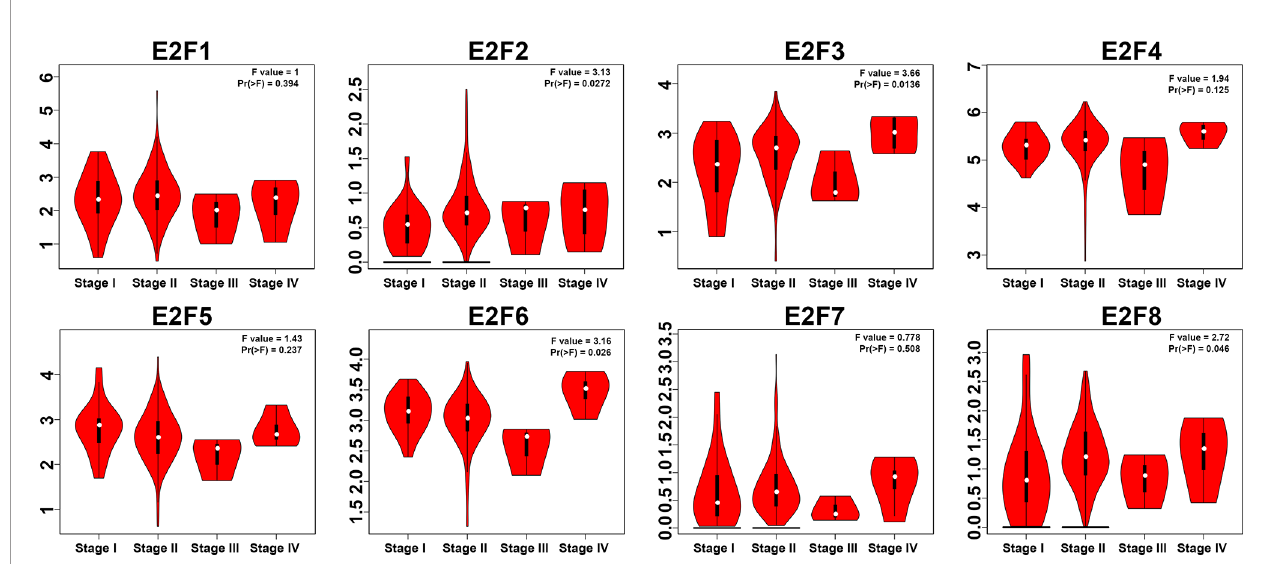
FIGURE 3 | Correlation between E2Fs expression and Tumor Stage in PAAD patients (GEPIA).